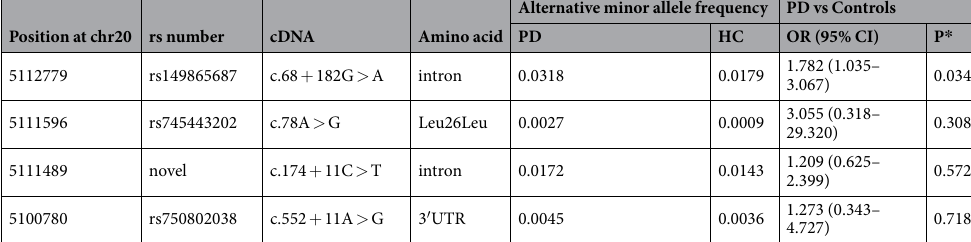
Table 1. Alternative minor allele frequencies of identified TMEM230 variants. * P Value was determined using the Pearson’s χ 2 test. PD: Parkinson’s disease; HC: Healthy control; OR: odds ratio; CI: confidence